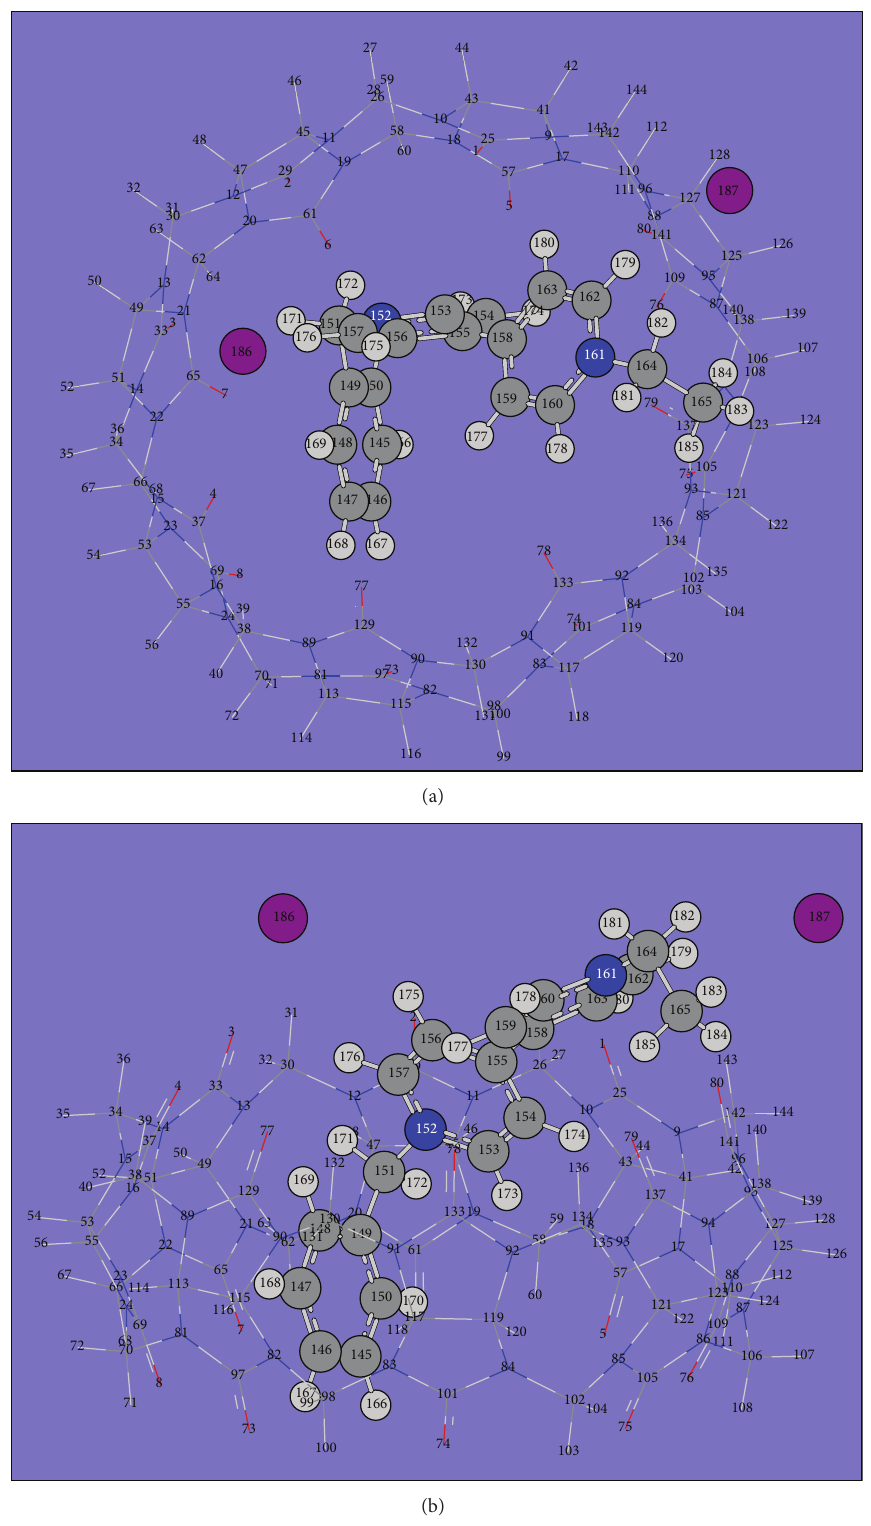
Figure 3: Optimized geometry of the inclusion complex BEV-I 2 /CB [8] viewed from top (a) and front (b). To aid visualization, CB [8] is in stick representation and the viologen salt in ball and stick representation with the iodide atoms in